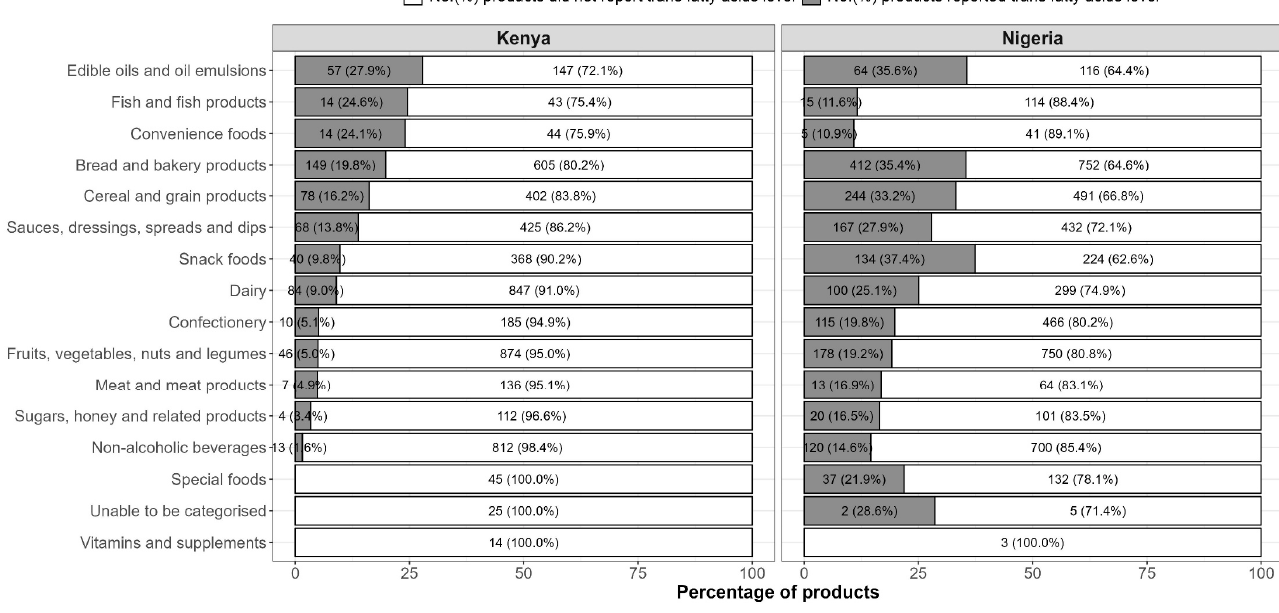
Figure 1. Number and percentage of products reported and did not report trans-fatty acids level by major food groups in Kenya and Nigeria. Table 2. Levels of reported trans fat in Kenya and Nigeria for different food